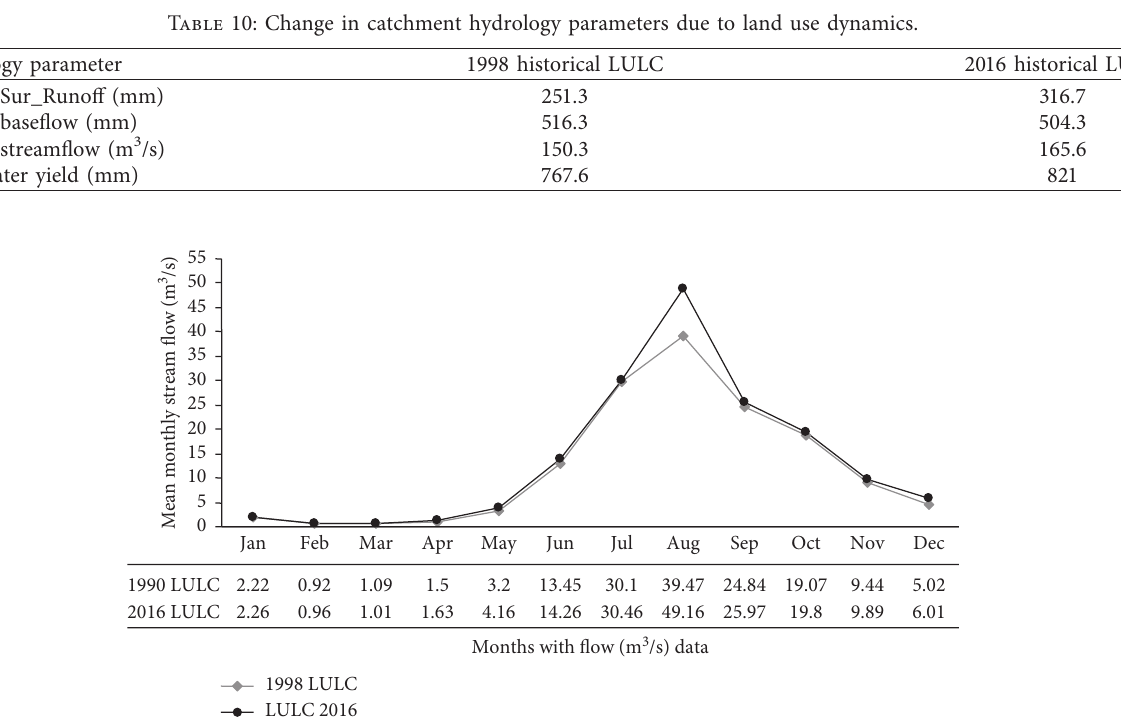
Figure 14: Simulated streamflow comparison under land use dynamics (2004–2018).